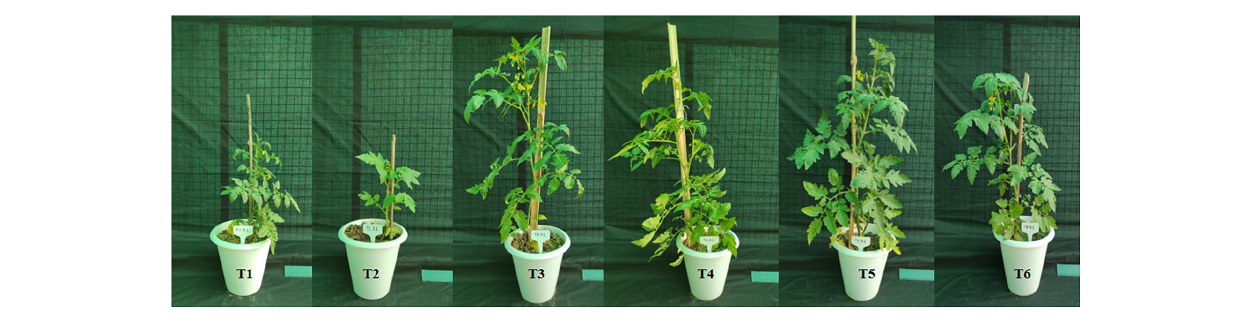
methods, gel retardation experiments, and electron microscopy (Zhang et al.,